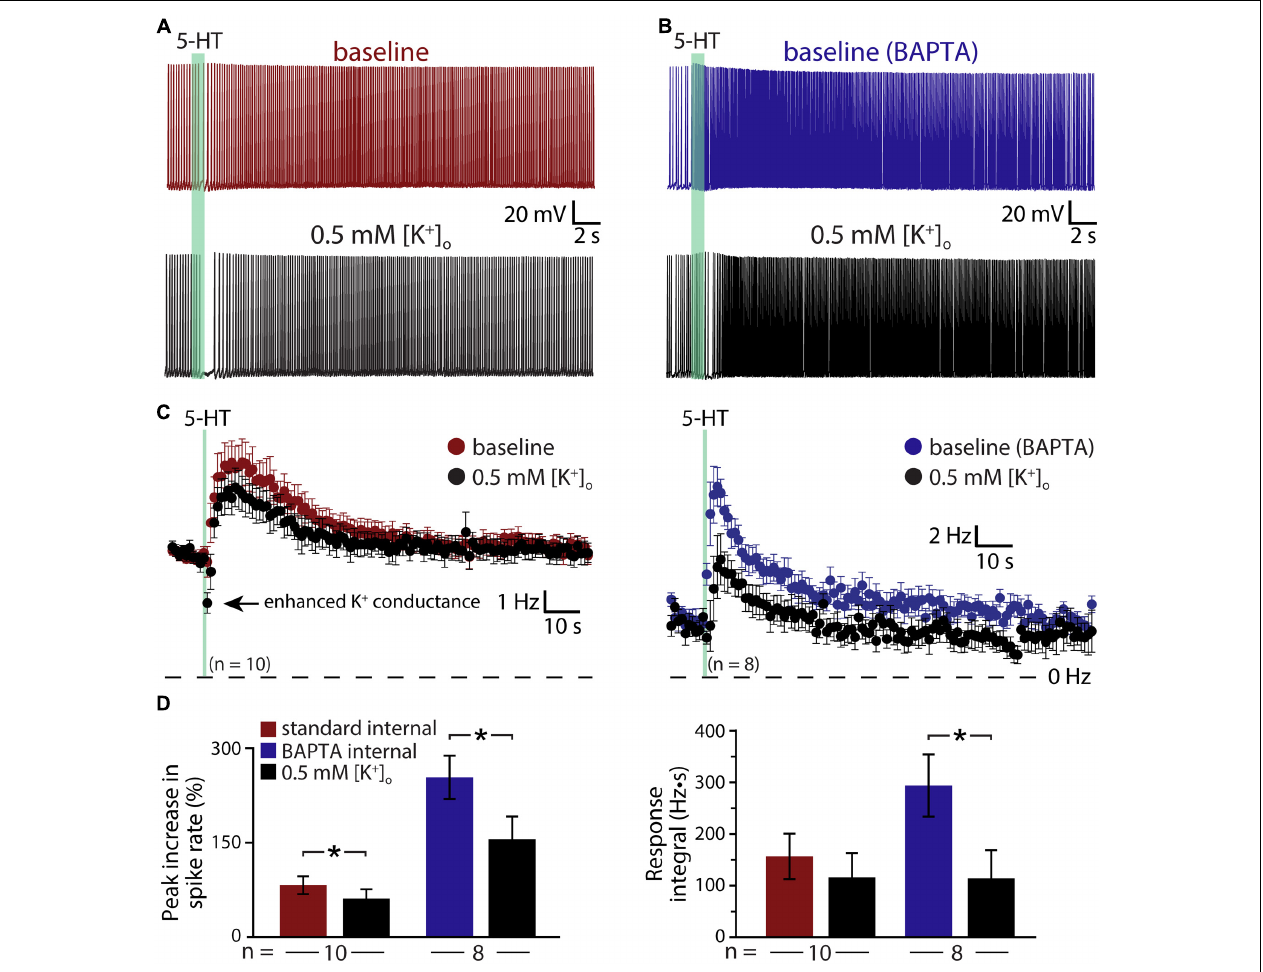
FIGURE 7 | Serotonergic excitation of COM neurons involves activation of non-selective cation conductances. (A,B) Responses to 5-HT (green bars) in baseline conditions and after reducing extracellular potassium to 0.5 mM (black traces) in control (red, A ) or BAPTA-filled (10 mM, blue, B ) COM neurons. (C) Plots of mean instantaneous spike frequencies for COM neurons in baseline (red or blue) and low [K + ] o (black) conditions for neurons recorded with standard intracellular solution or with BAPTA included, respectively. (D) Comparisons of peak increases in instantaneous spike frequencies (left) and response integrals (right) in baseline conditions (red or blue) and after lowering [K + ] o to 0.5 mM